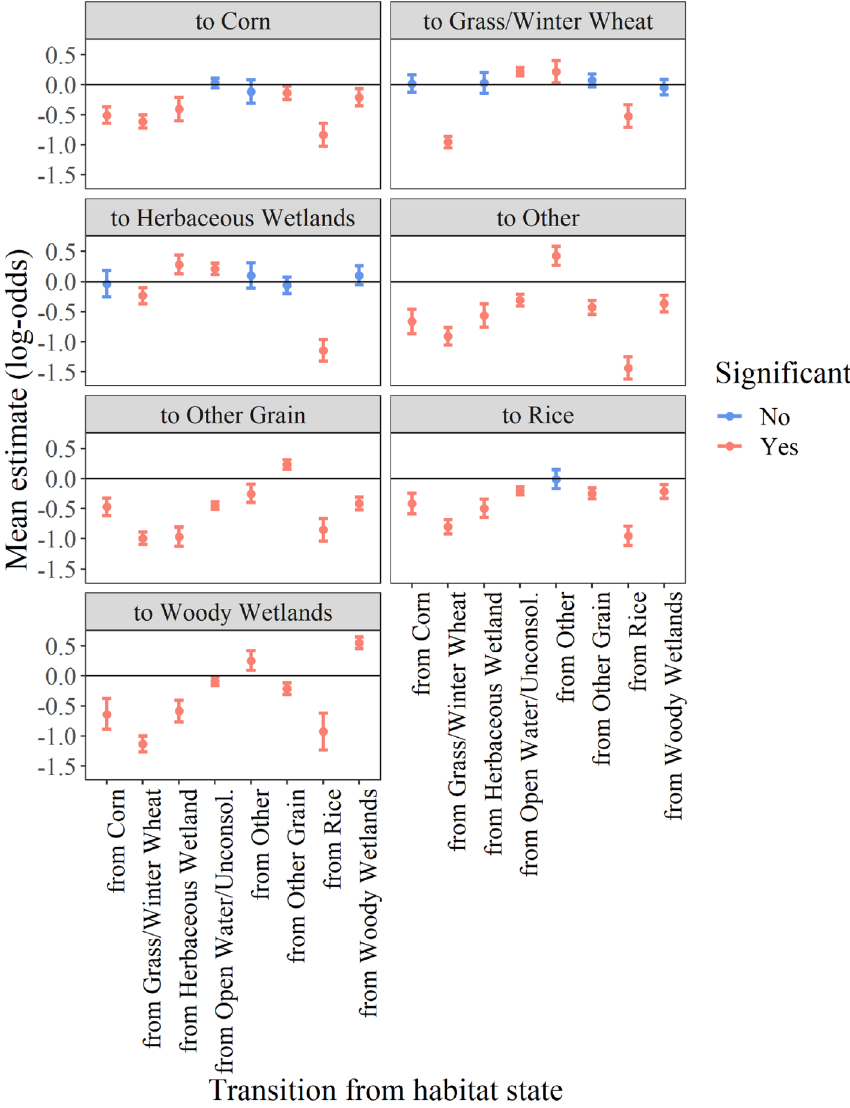
Figure 5. Mean effect on transition-specific probability (± 95% credible intervals; log-odds scale) of transitioning between all combinations of landcover types for ambient temperature (°C) derived from tracking devices. Negative estimates reflect transitions that were more probable at lower than average temperature, and positive estimates at higher than average